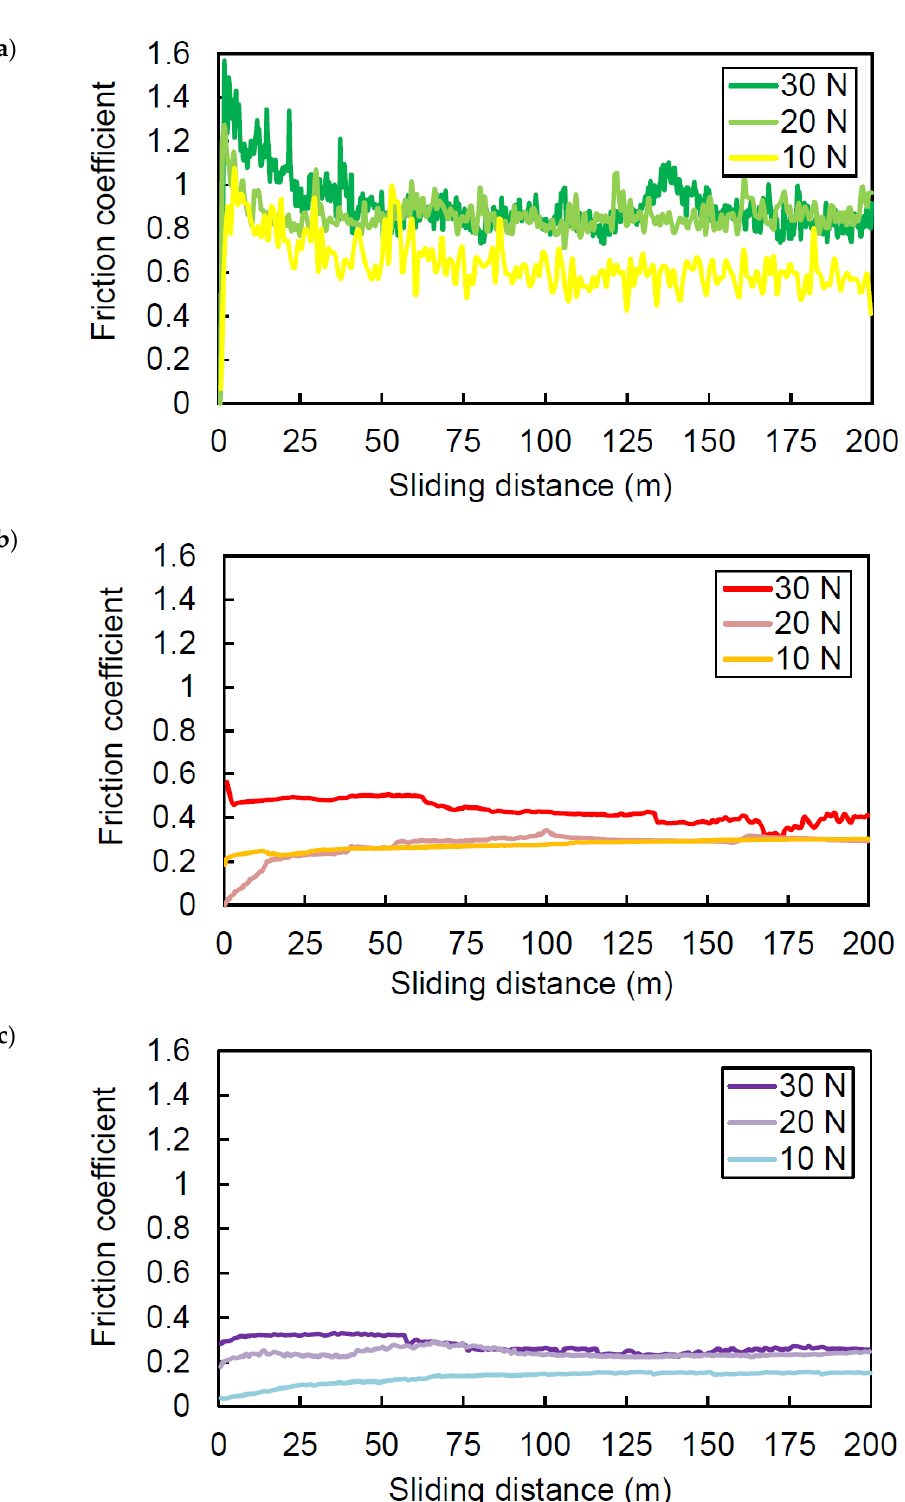
Figure 9. Friction coefficient variations with sliding distance for ( a ) A356 substrate, ( b ) Cr 3 C 2 -NiCr, and ( c ) WC-Co-Cr coating under different applied loads.